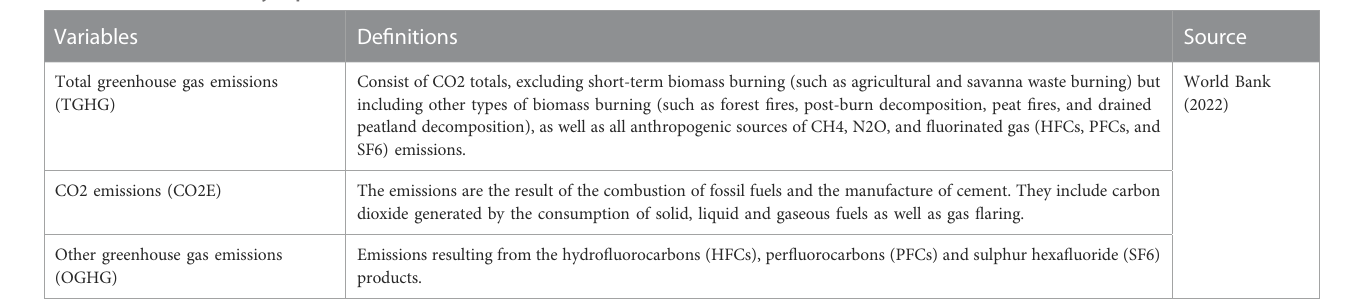
TABLE 3 De fi nitions of study dependent